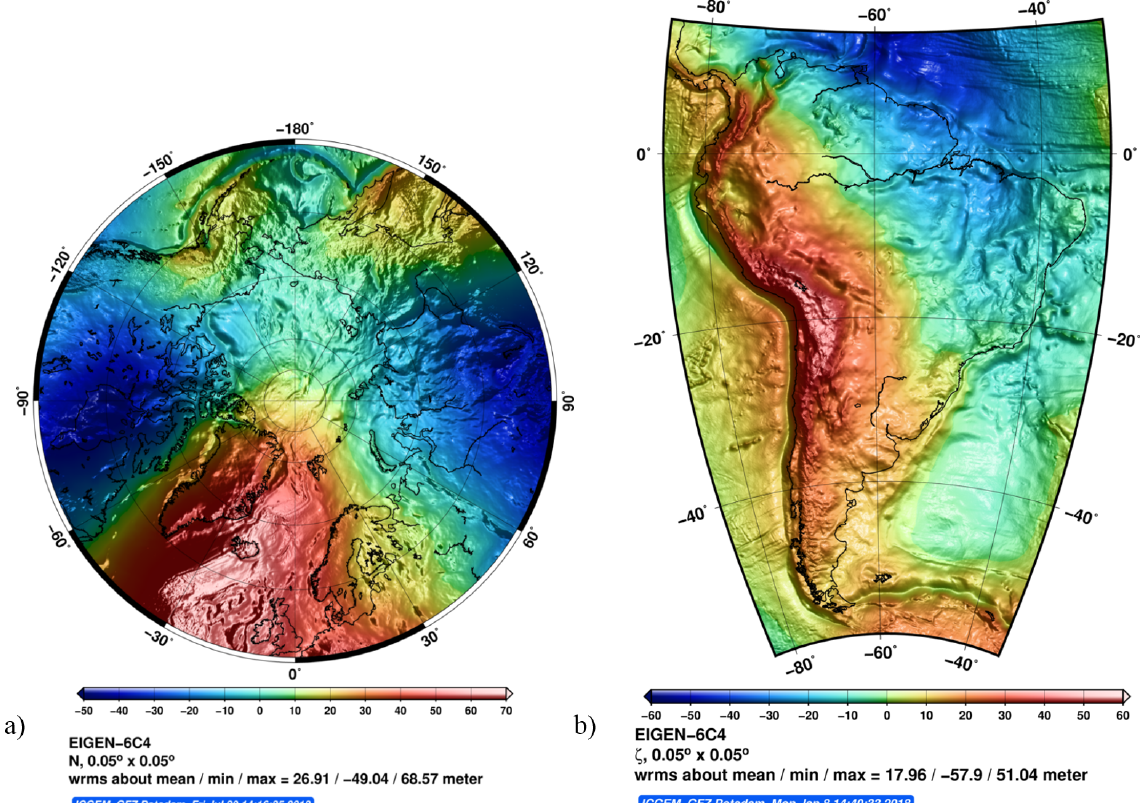
Figure A1. Different projections are introduced in the background script which uses GMT version 5.0. The figures are adjusted based on the calculation area. The below figures show geoid undulations and height anomalies in (a) the Northern Hemisphere above 50 degrees latitude and (b) South